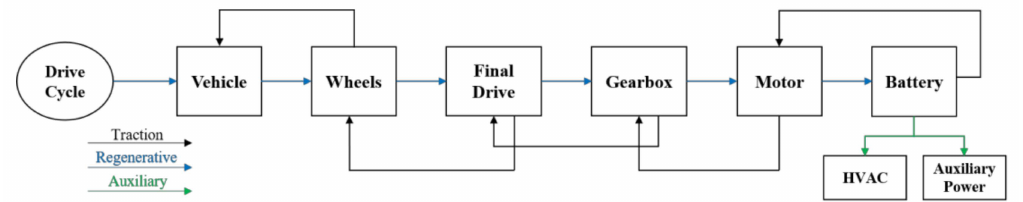
Figure 3. MATLAB Simulink model configuration for BEB